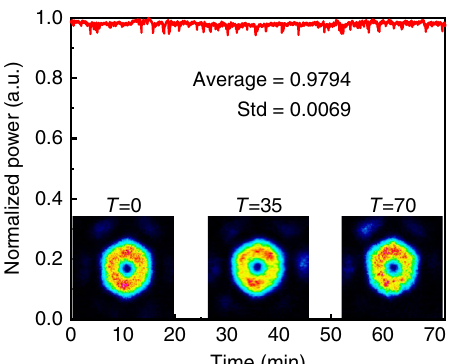
Fig. 7 Long-term stability. The normalized power of the correlation signal collected by the SMF, indicating stable phase locking over 70 min. The inserts are examples of beam intensity pro fi les measured at different times, showing that the doughnut-shaped beam was well preserved during the